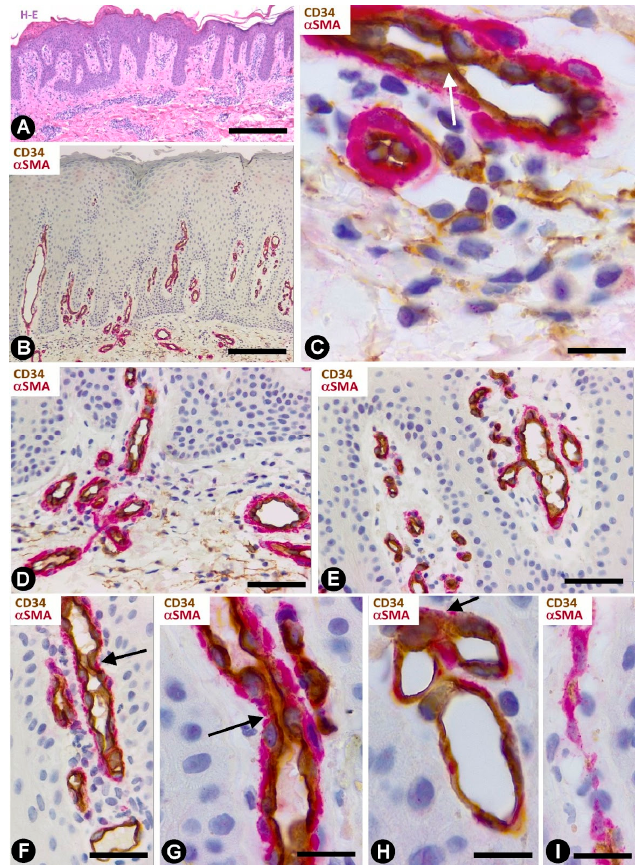
Figure 9. CD34+SCs/TCs in psoriasis. ( A ) Tissue section stained with hematoxylin and eosin, showing elongated rete ridges and a superficial perivascular inflammatory lymphocytic infiltrate. ( B – I ) Double immunochemistry for CD34 (brown) and α SMA (red). Hematoxylin counterstain. Vessels in the superficial layer extend and penetrate the papillary dermis between the elongated rete ridges ( B , arrows). Some CD34+SCs/TCs are observed around vessels between the superficial inflammatory infiltrates ( C ), but are absent in the papillary dermis ( D – I ). Vessels in the papillary and superficial dermis present interendothelial apical ( C , F , arrows) and planar ( G , arrow) contacts, folds with incarcerated pericytes ( H , arrow) and occasional regressive phenomena ( I ). Bar: ( A , B ) 150 µm, ( C , G , H , I ) 25 µm, ( D , E , F ) 80 µm.